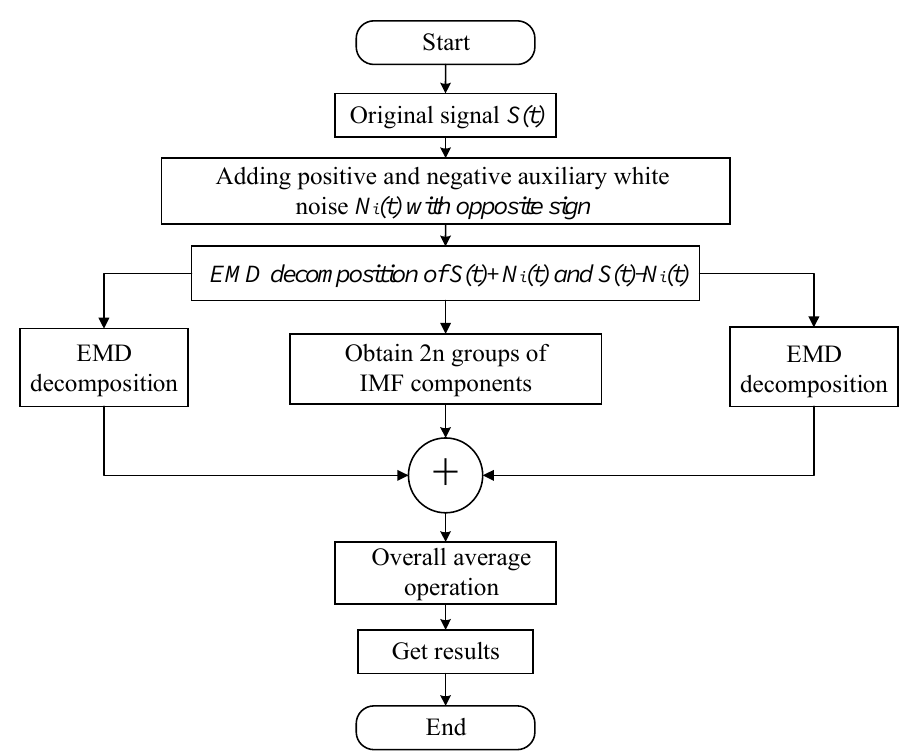
Figure 10. CEEMD decomposition flow chart.